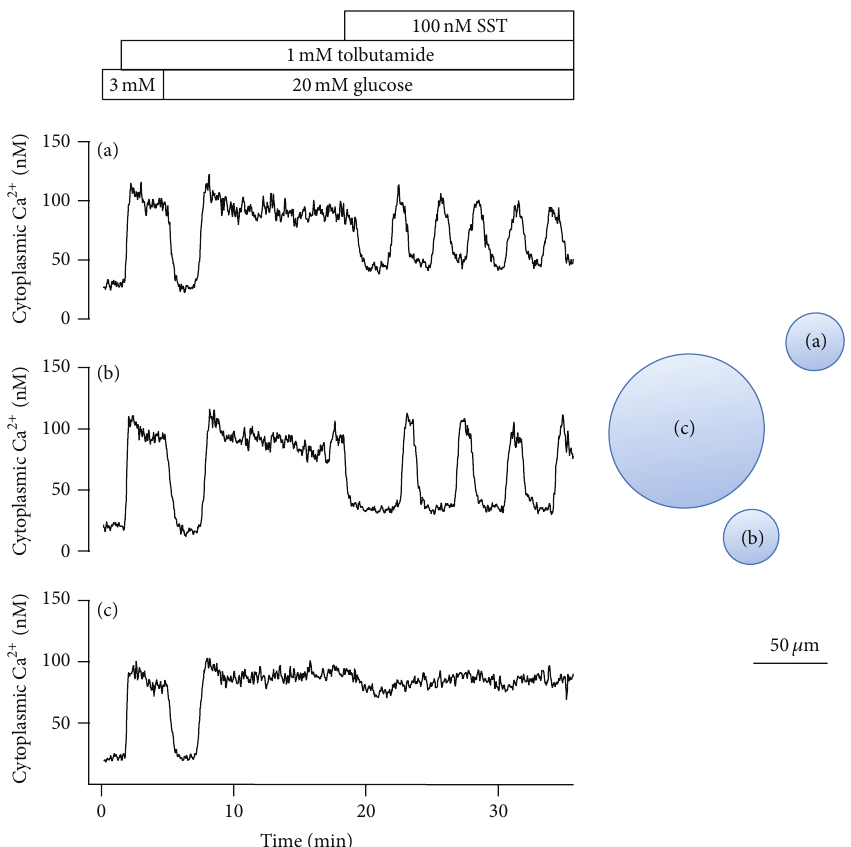
Figure 4: Effects of 100 nM somatostatin on the cytoplasmic Ca 2+ concentration in one big and two small islets after elevation of glucose in the presence of 1mM tolbutamide. Exposure to somatostatin resulted in glucose-dependent oscillations mediated by periodic interruption of elevated Ca 2+ in 42 of 47 of the small islets and in 4 of 13 of the big